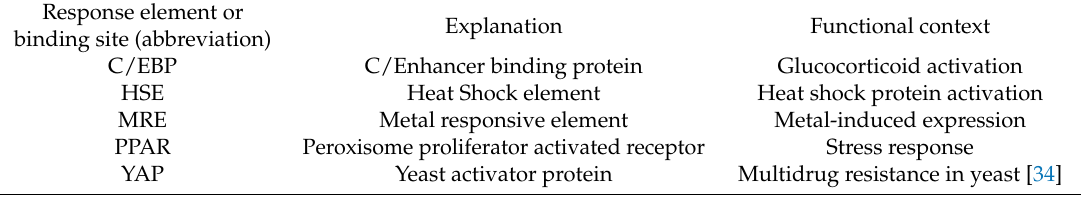
Theoretical binding sites for transcription factors involved in stress-response and transcriptional regulation from the promoter region of Biomphalaria glabrata . Abbreviated terms indicate the binding sites and suggested functional context according to explanations in TRANSFAC databases (see materials and